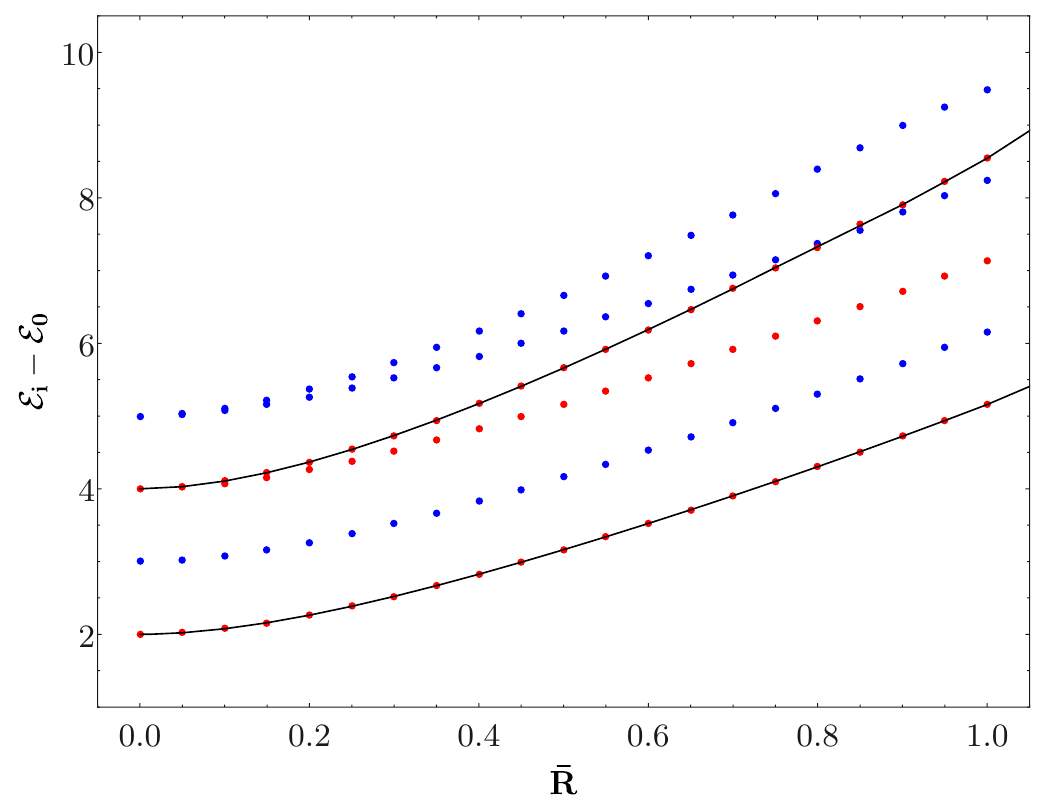
¯ λ > 0 , as a function of the